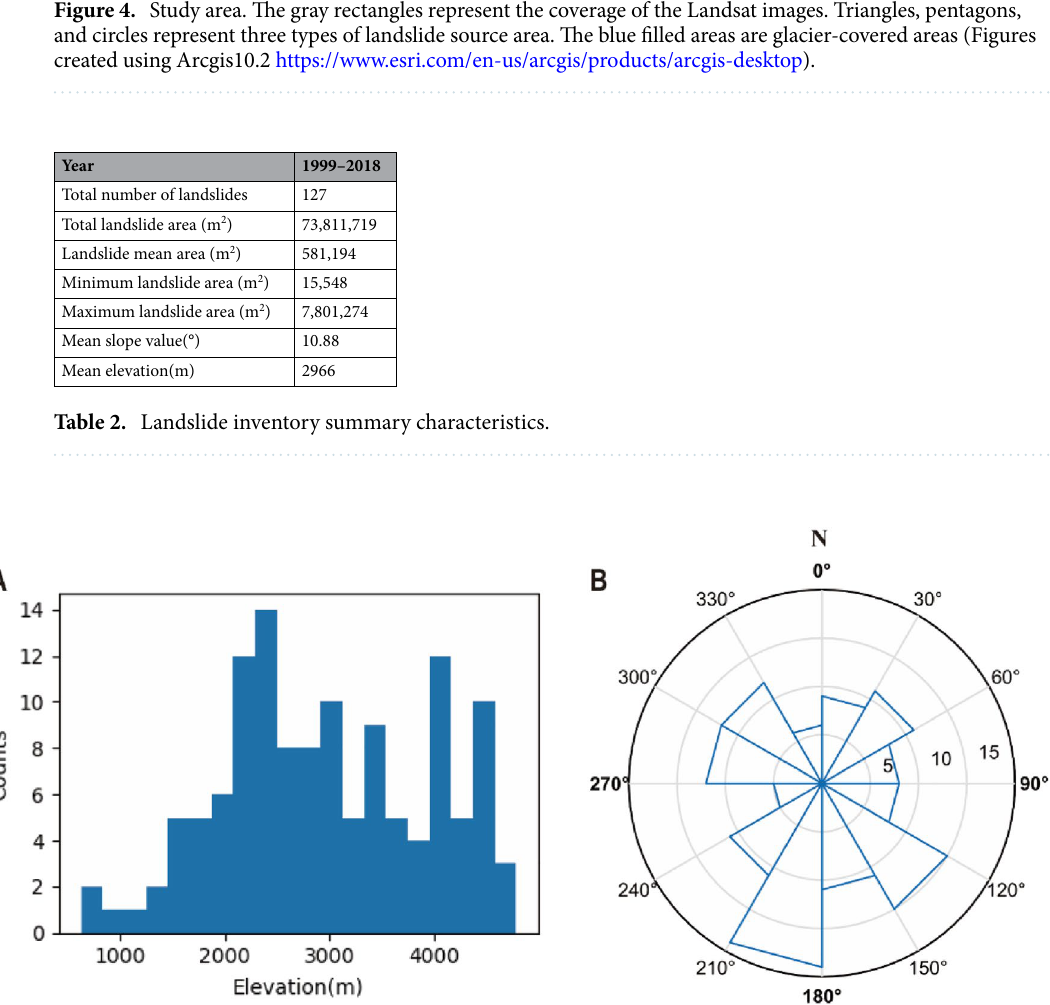
Figure 5. Variation in ( A ) elevations and ( B ) aspects for landslide from a 30-m DEM. Aspects are shown on a 360° Rose diagram. Numbers on circles are counts within that